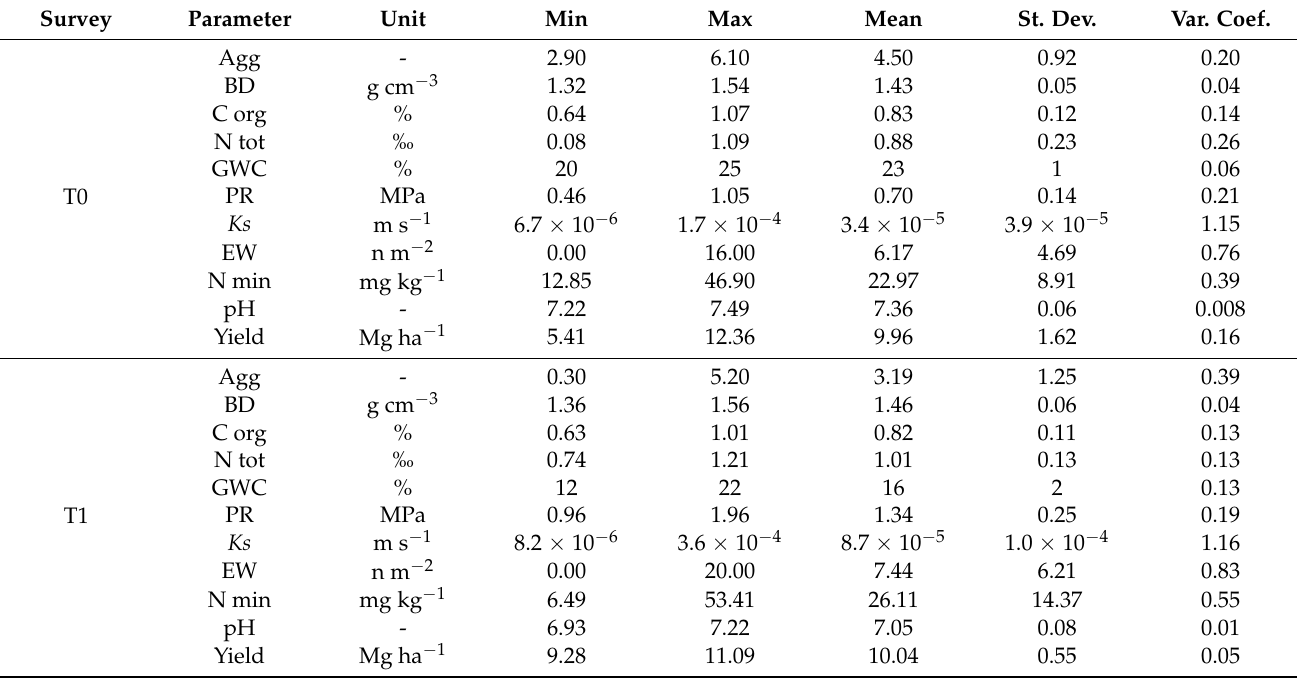
Table 3. Descriptive statistics of studied parameters for T0 and T1 surveys (Agg—aggregate stability; BD—bulk density; C org—soil organic carbon; N tot—soil total nitrogen; GWC—gravimetric water content; PR—penetration resistance; Ks —saturated hydraulic conductivity; EW—earthworm density; N min—mineral nitrogen; St. Dev.—standard deviation; Var. Coef.—coefficient of